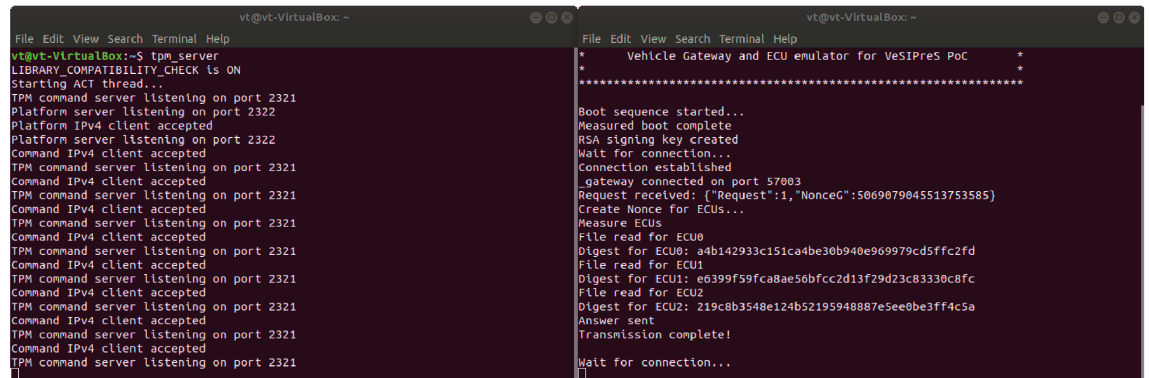
Figure 8: Screenshot of the vehicle simulation running on a desktop environment. The left console shows the running TPM simulator, and the right one shows the vehicle simulator.